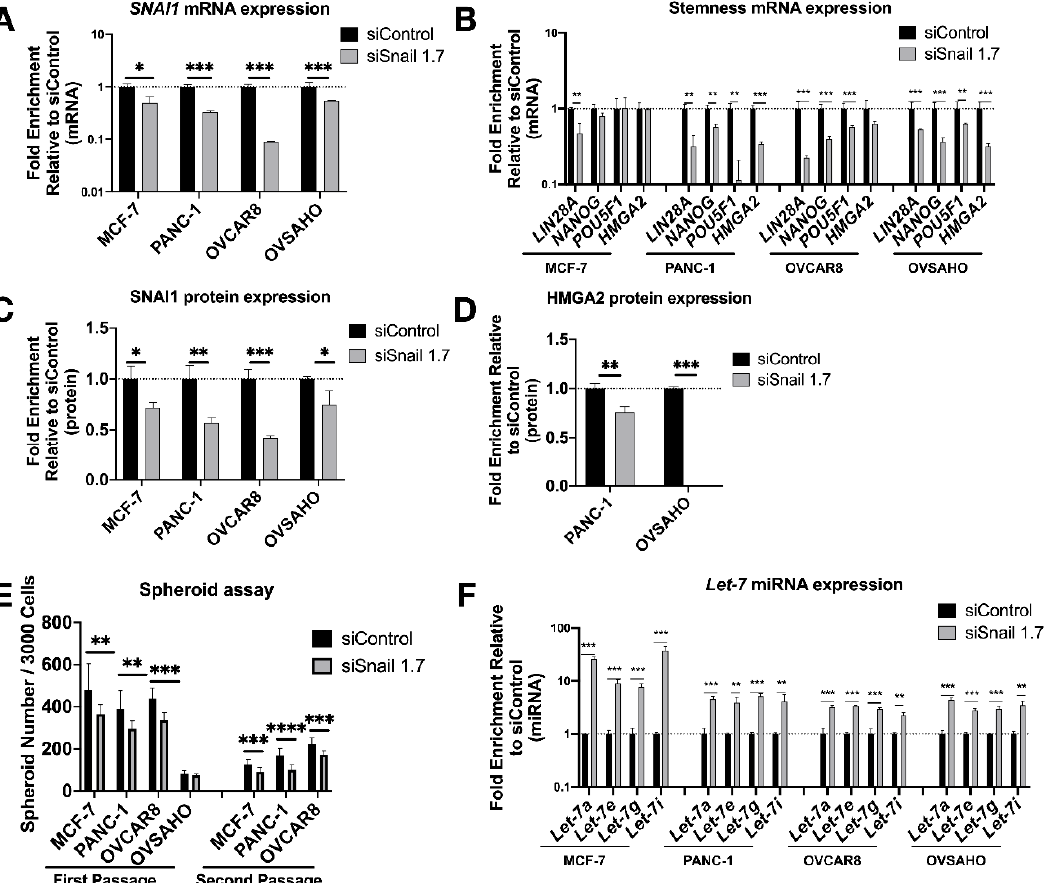
Figure 3. SNAI1 knockdown reverses stemness and restores let-7 expression. Mesoporous silica nanoparticles coated with hyaluronic acid (HA-MSN) were used to deliver siRNA (siSnail and siControl) in MCF-7, PANC-1, OVCAR8, and OVSAHO. Levels of control group (cells treated with siControl) were normalized to 1. Values for RT-qPCR are shown on a log scale. Samples were harvested after 24 h (MCF-7, OVCAR8 and OVSAHO) or 72 h (PANC-1). ( A , B ) RT-qPCR analysis for mRNA expression of SNAI1 ( A ) and of stemness markers LIN28A , NANOG , POU5F1 and HMGA2 ( B ). ( C , D ) The quantification of Western blot analysis for protein expression of SNAI1 ( C ) and HMGA2 ( D ). ( E ) The quantification of number of spheroids formed per 3000 cells (both first passage and second passage) as indicated. ( F ) RT-qPCR analysis for let-7 miRNA ( let-7a , let-7e , let-7g , and let-7i ) expression. * p < 0.05; ** p < 0.01; *** p < 0.001; **** p < 0.0001